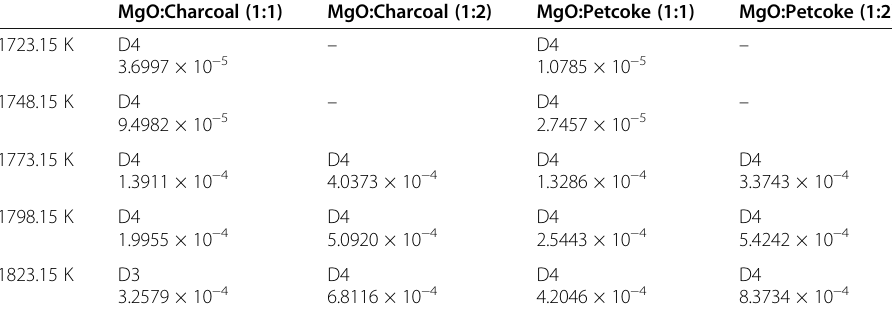
Table 3 The abbreviations of selected kinetic equations and also the corresponding optimized values of k /min − 1 for reactions of MgO with carbonic reductants in different molar ratios and at different